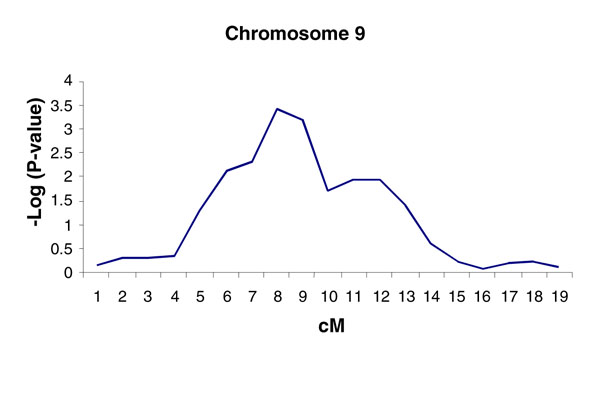
Multi-point linkage analysis of SRMAXAPD (outliers removed).